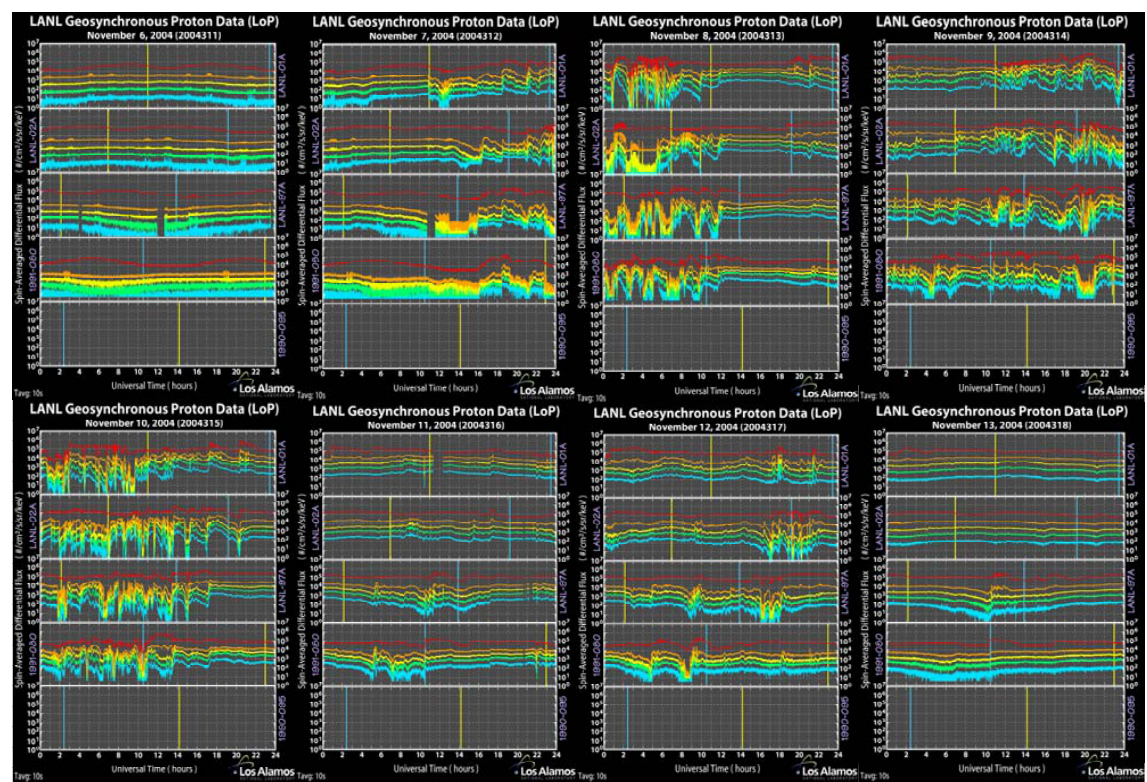
Fig. 21. Spin averaged (10s), differential, proton fluxes recorded in geosynchronous orbit aboard several LANL spacecraft between 6–13 November 2004 in channels 30–45keV, 50–75keV, 75–105keV, 105–150keV and 150–315keV (bottom trace). Preliminary/quick-look